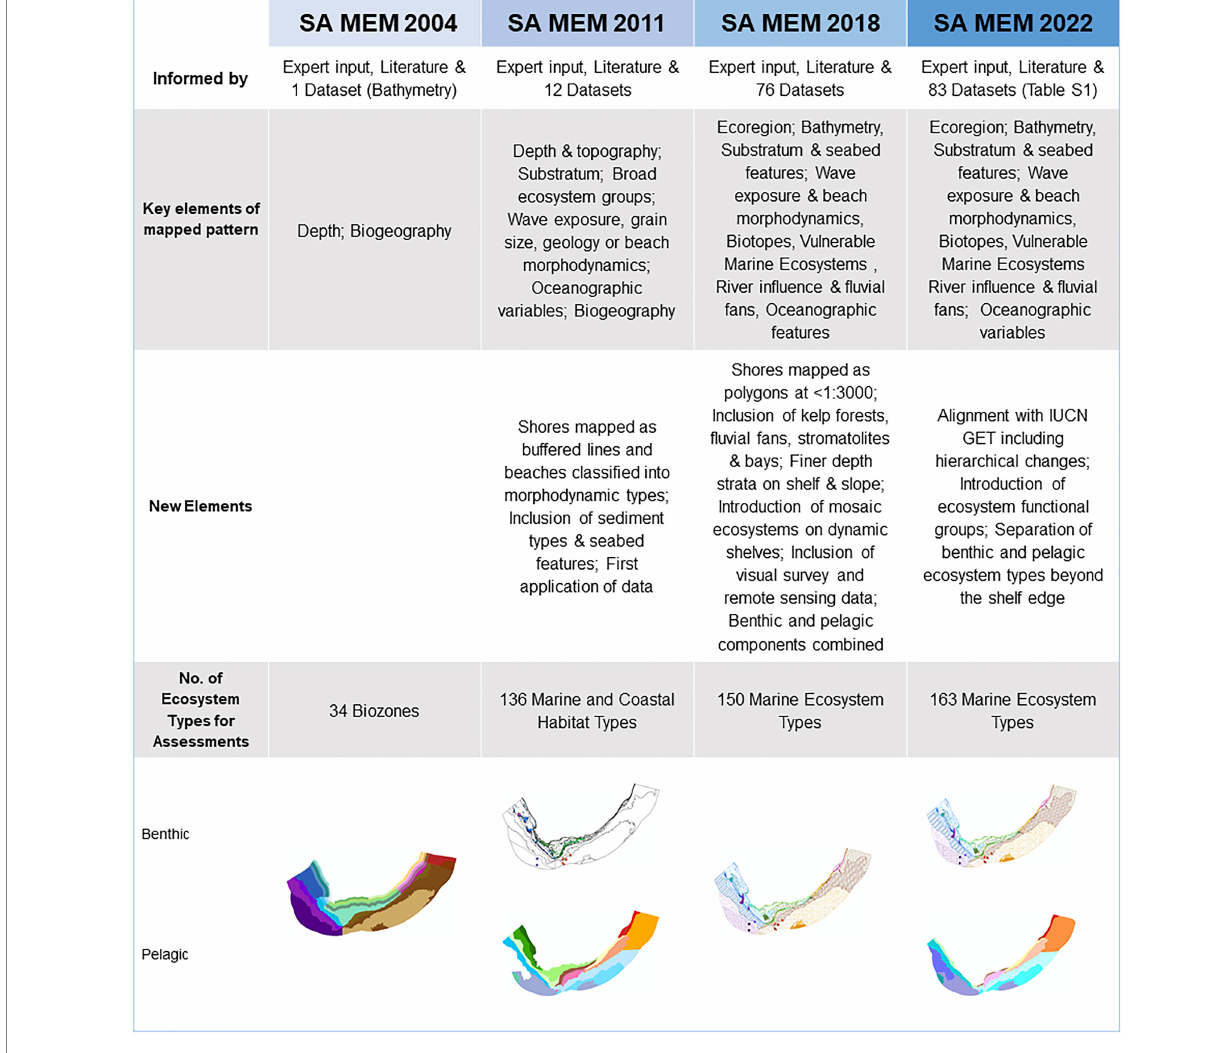
FIGURE 2 Schematic illustrating the evolution of South Africa’s national marine ecosystem map (SA MEM) used to assess ecosystem threat status and protection level between 2004 and 2022 in South Africa. This evolved from a literature- and expert-based approach to a data-informed but expert-driven method drawing from 83 multi-disciplinary datasets with recent changes to align with the IUCN Global Ecosystem Typology (IUCN GET). Note that the key elements of mapped patterns are listed hierarchically as they were applied in the